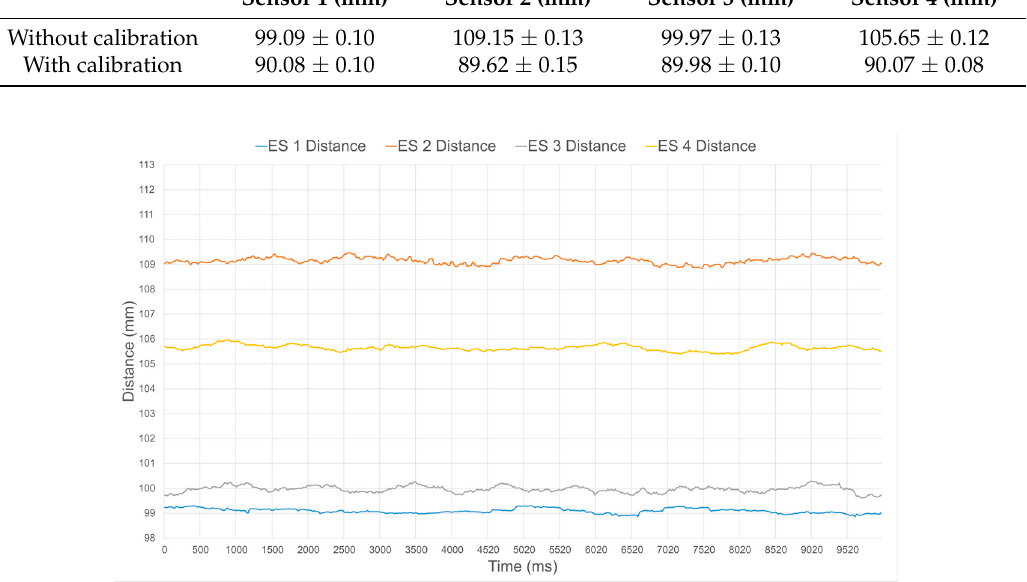
Figure 16. Uncalibrated distance estimates from four IR range sensors for ground truth distance of a surface located 90 mm in front of the compliant wrist.